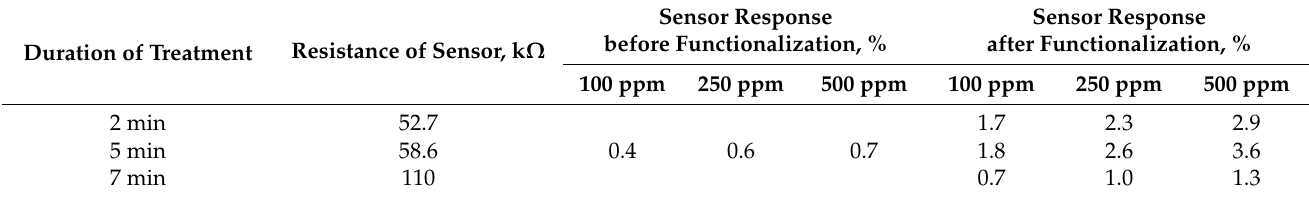
Sensor Response after Functionalization, %